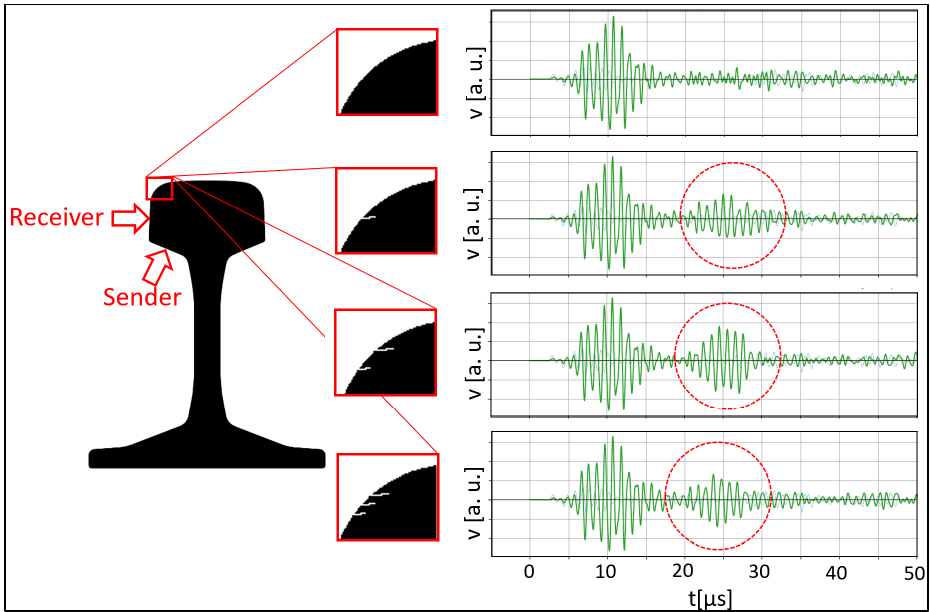
Figure 8. Simulated signal as received at position HL, without crack, and due to reflection at 1 crack, 2 cracks, and 3 cracks, respectively. The crack depth as shown in the sketch is 0.5 mm. The red circles mark the part of the signal coming from the interaction with the cracks. v denotes the velocity component at the receiver position, projected to the surface normal.